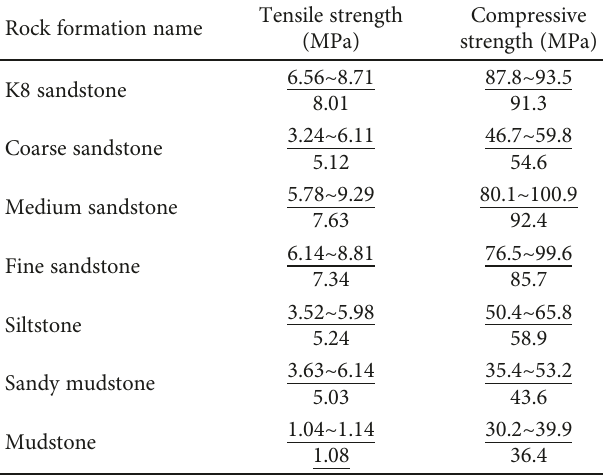
Table 9: Rock mechanical parameter measurements of overlying strata in Yuwu coal mine